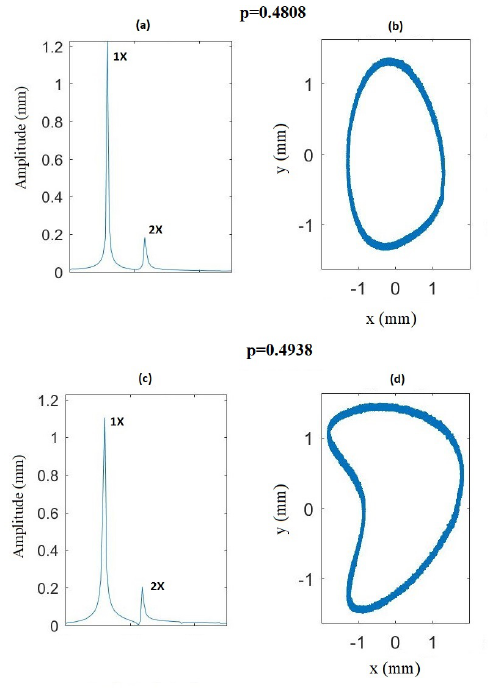
Figure 22. Comparison of the results at two different rotation speeds for α = 0.15: ( a ) FFT at p = 0.4808, ( b ) orbit at p = 0.4808, ( c ) FFT at p = 0.4938 ( d ) orbit at p =